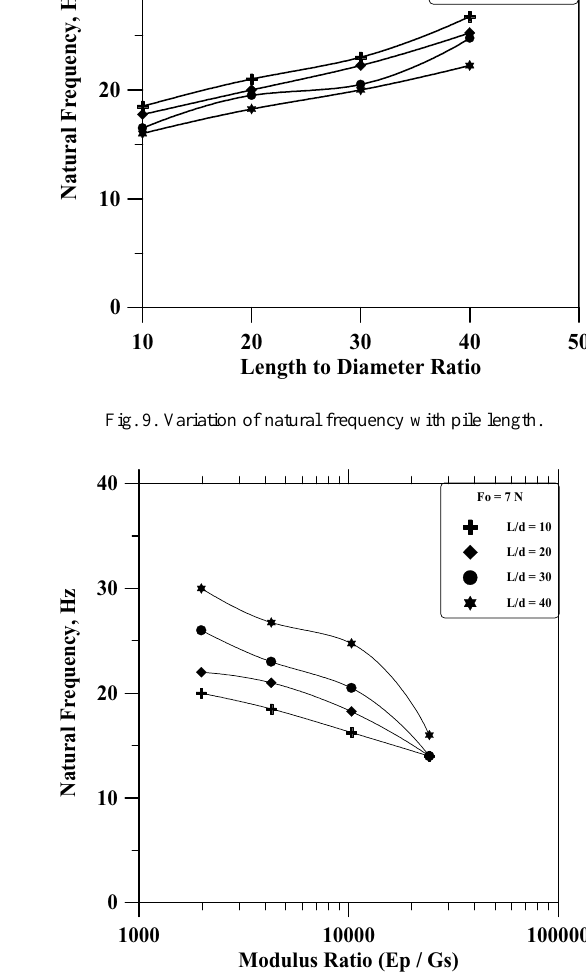
Fig. 10. Variation of natural frequency with modulus